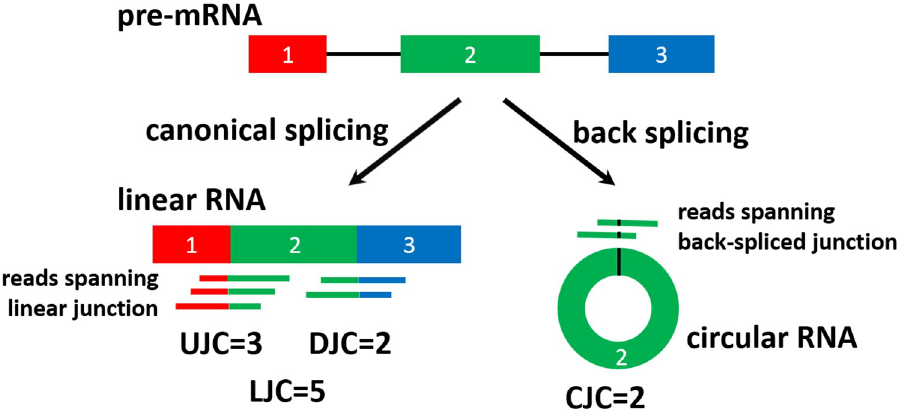
Fig 3. Different types of junction counts. UJC: upstream junction count, DJC: downstream junction count, LJC: linear junction count (UJC+DJC), CJC: circular junction count.